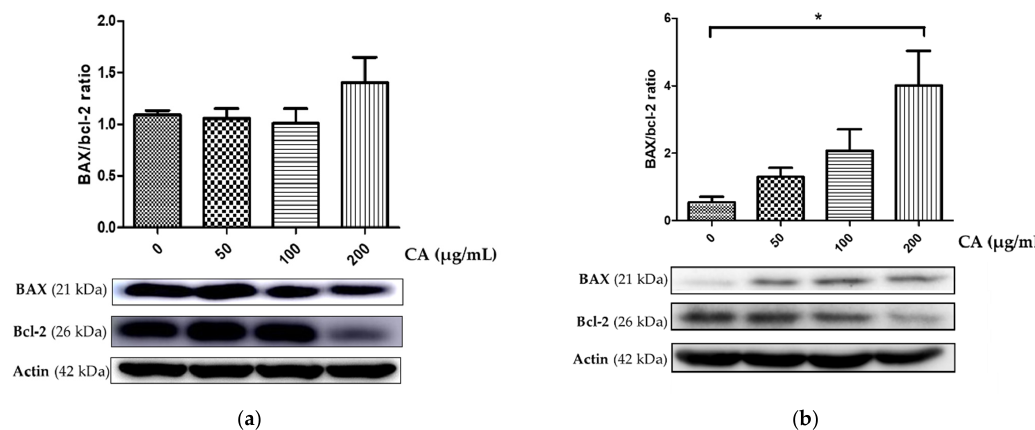
Figure 3. BAX and Bcl-2 protein expression of ( a ) KKU-100 and ( b ) KKU-213 after treatment with CA for 48 h. (* = statistically significant; p -value < 0.05).